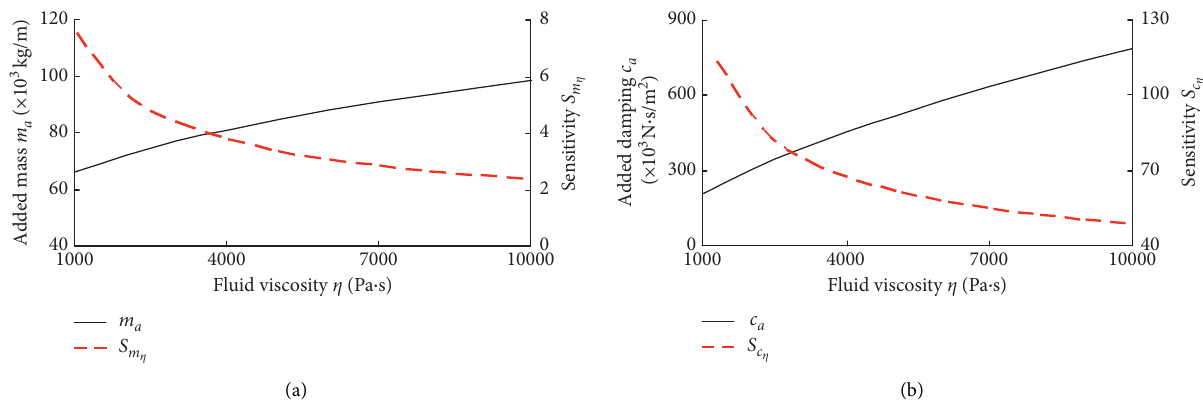
Figure 3: Influence of fluid viscosity on the added mass (a) and added damping